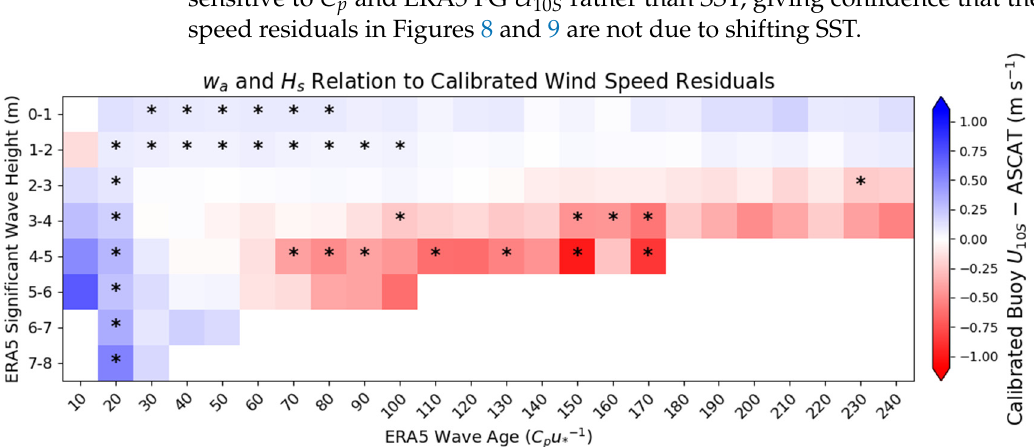
Figure 9. Average calibrated wind speed residuals (calibrated buoy U 10 S –ASCAT) organized by w a and H s . u ∗ in w a is calculated with ERA5 model first guess winds. Squares with an asterisk (*) indicate statistically significant differences between the ASCAT and calibrated buoy U 10 S values for the given w a and H s range defined using Welch’s t -test with a p -value limit of 0.05.